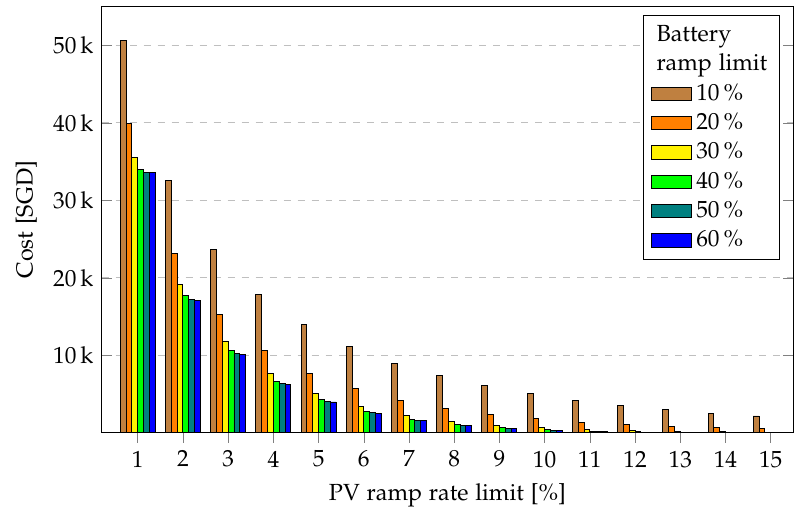
Figure 8. PV ramp cost over PV ramp rate limit for various battery ramp limits for one